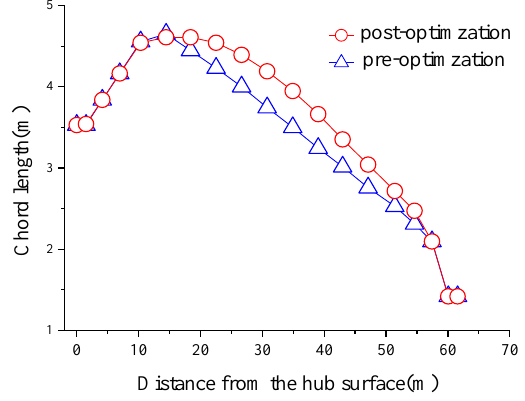
Figure 15. Distribution of the chord length at rated wind speed before and after smoothing.